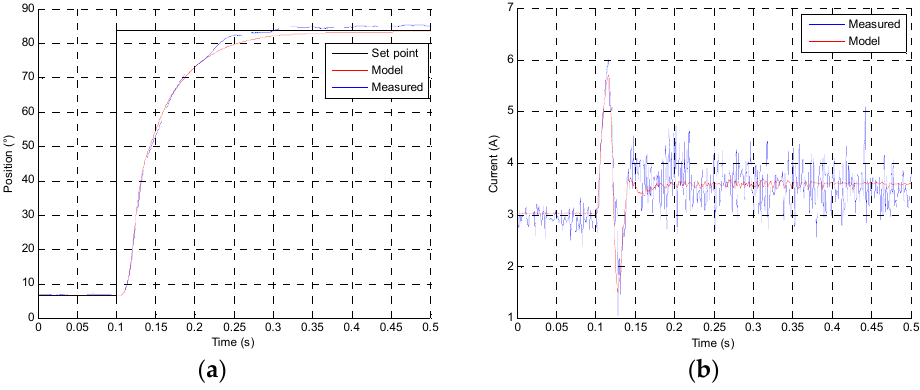
Figure 16. ( a ) Position step response comparison between measure and direct drive model; ( b ) Current response comparison between measure and direct drive model at 12 V and 25 °C conditions.